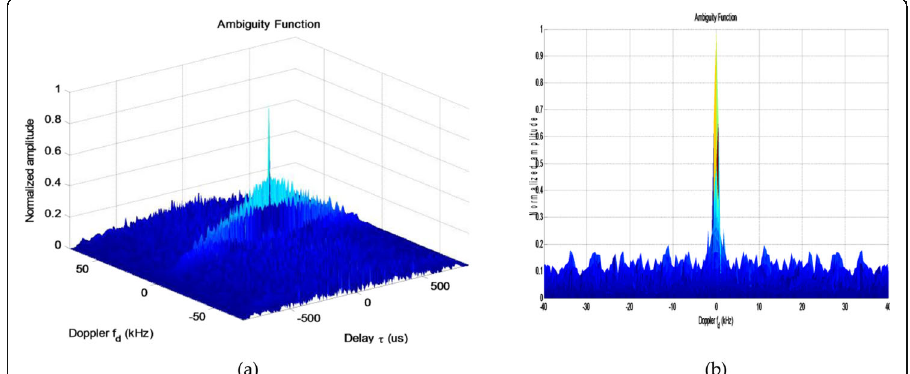
Fig. 6 a Doppler tolerance of f C 1 . b Amplitude v/s Doppler of f C